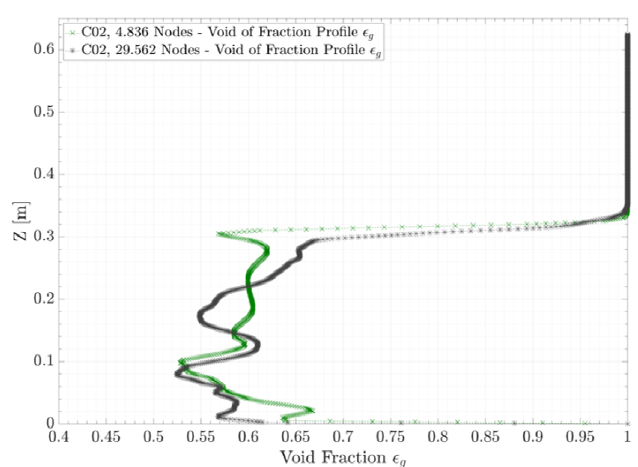
Figure 11. Main CFD results. Comparison between solutions obtained by considering the coarsest and finest mesh: ( a ) void fraction profiles at centerline in the two chambers; void fraction profiles as function of the bed height in the down-flowing bed (DFB) ( b ) and up-flowing bed (UFB) chamber ( c ). Plotted data were averaged over simulation time between 1 s and 20 s.